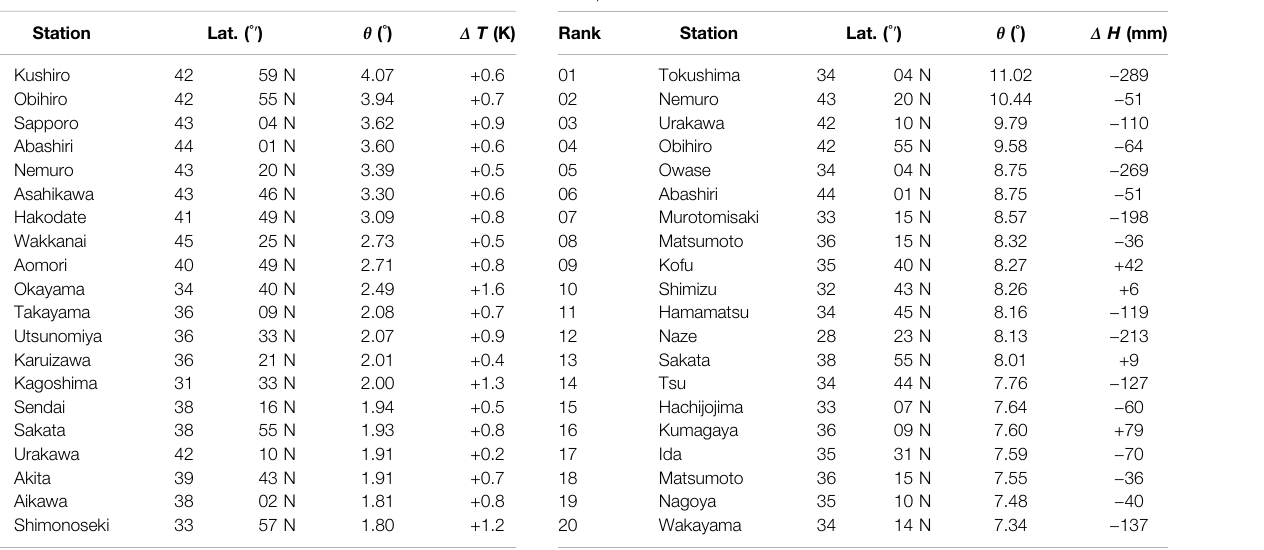
TABLE4B| Top-twentyJapanesestationsintheintersectingangleofthemonthly precipitations from Period II (from 1951 to 1980) to Period III (from 1981 to 2010).